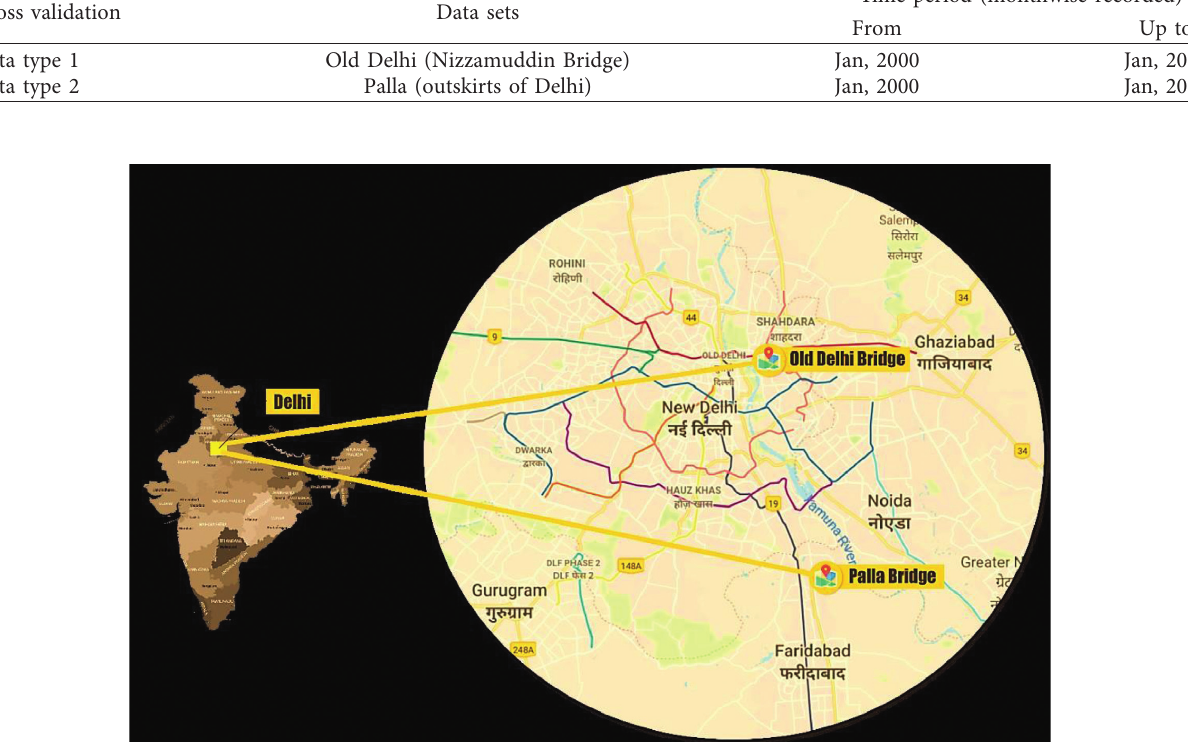
Figure 1: Map showing the two monitoring stations of river